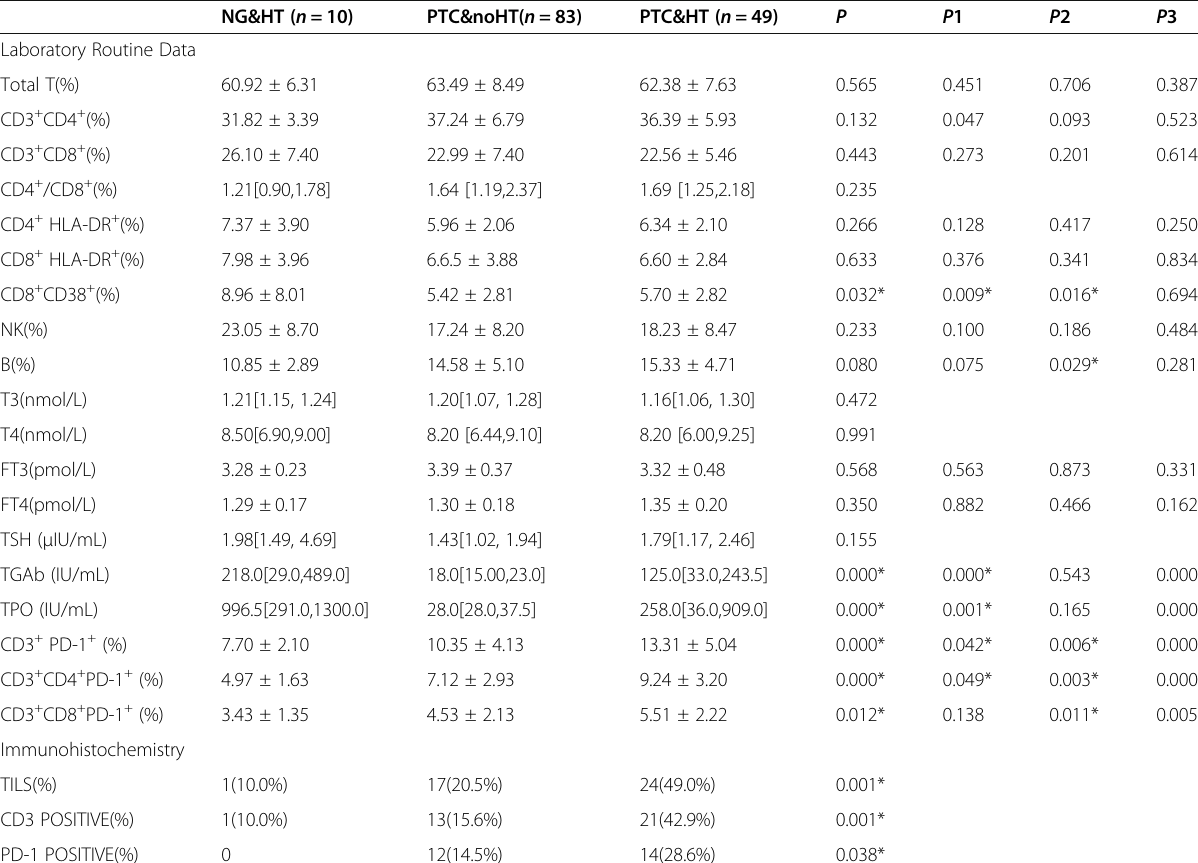
Table 2 The changes of lymphocyte subsets, thyroid function indexes and PD-1 among NG&HT, PTC&noHT and